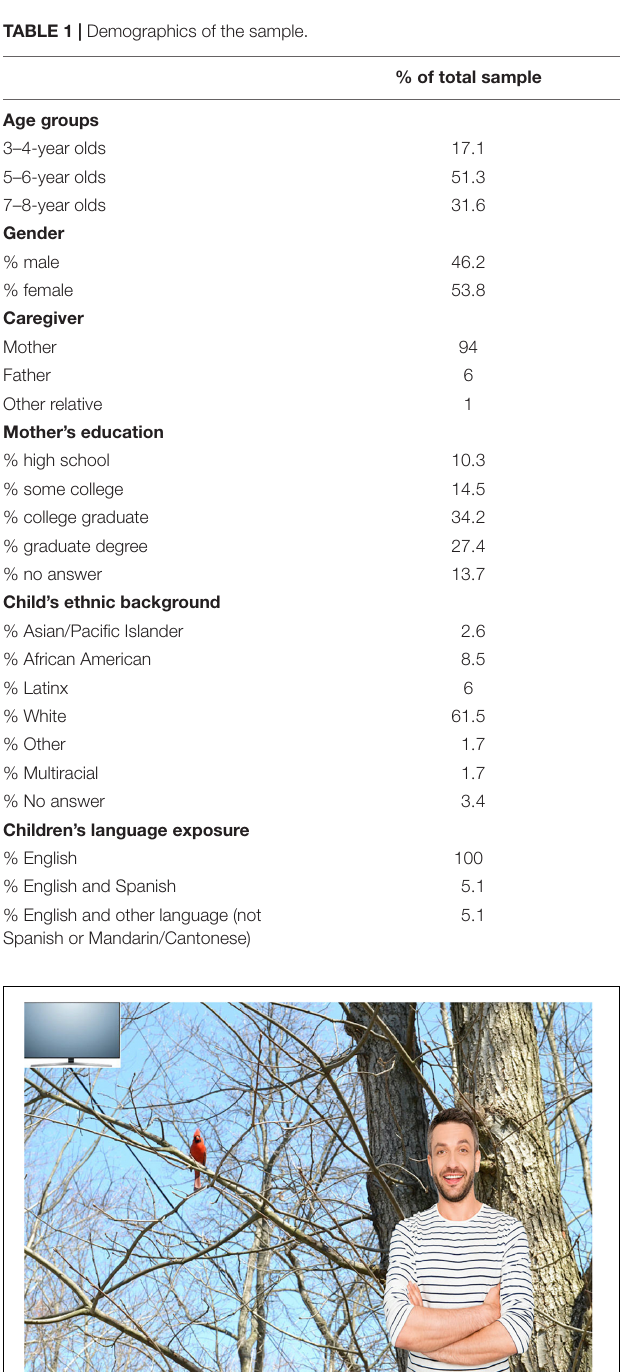
shows, such as Sesame Street and Wild Kratts , feature male animals and male adult characters. Birds are also a type of animal that all children in the sample would have seen